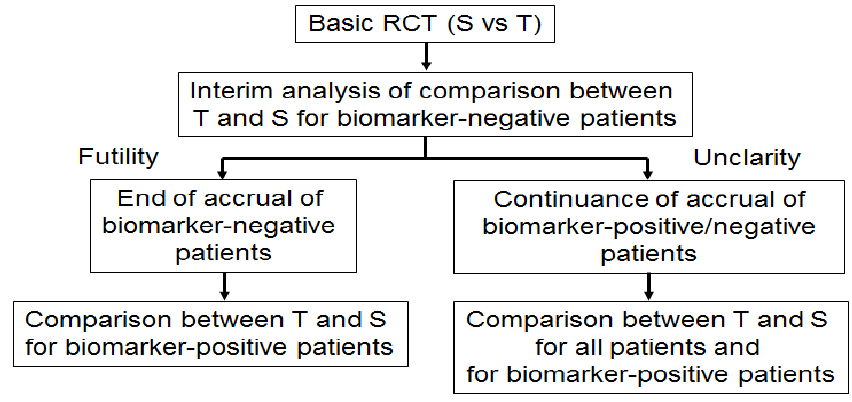
Figure 6. General procedure for adaptive accrual design. ‘S’ and ‘T’ denote the standard and test treatments,